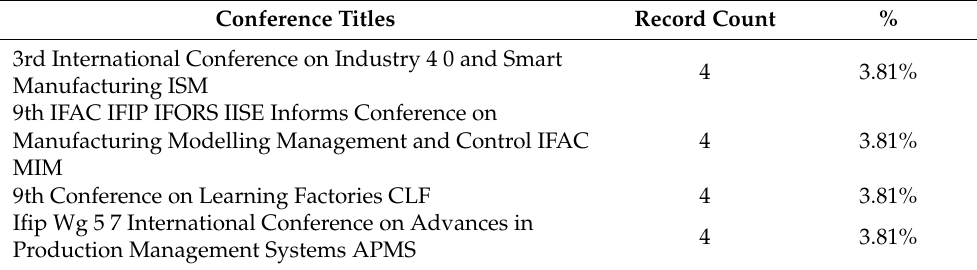
Table 4. Main source titles which contributed to the publication of post-conference scientific publica- tions related to Industry 4.0 in the SME sector; Source: own study.